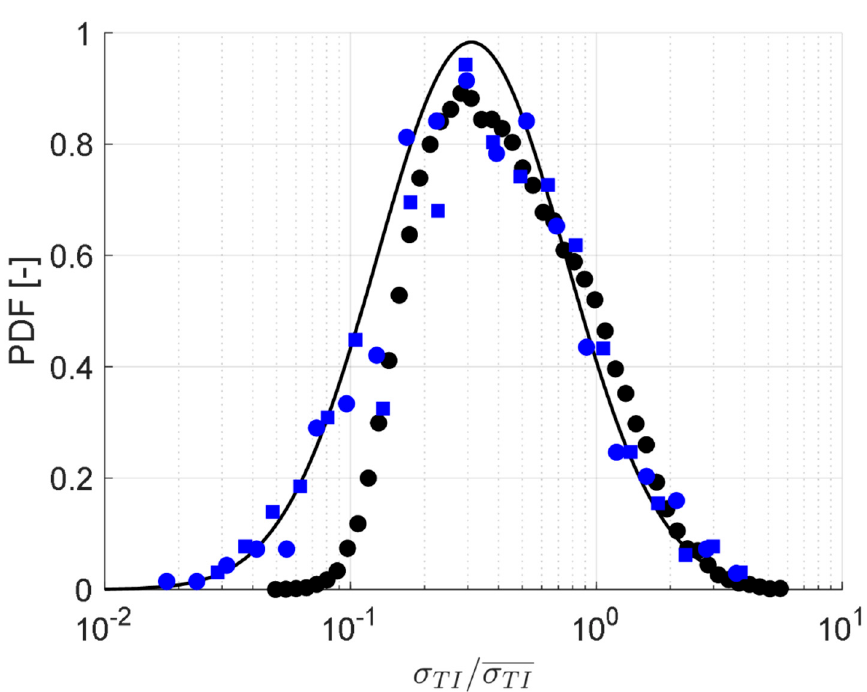
Figure 8. Experimentally measured PDF of instantaneous stresses calculated from particle image velocimetry results in the efficient region of breakup in a HPH geometry (black disks) [75] and in a batch RMS [74] operating at either 333 rpm (blue disks) or 1233 rpm (blue squares). Solid line: lognormal pdf with q = 0.34.